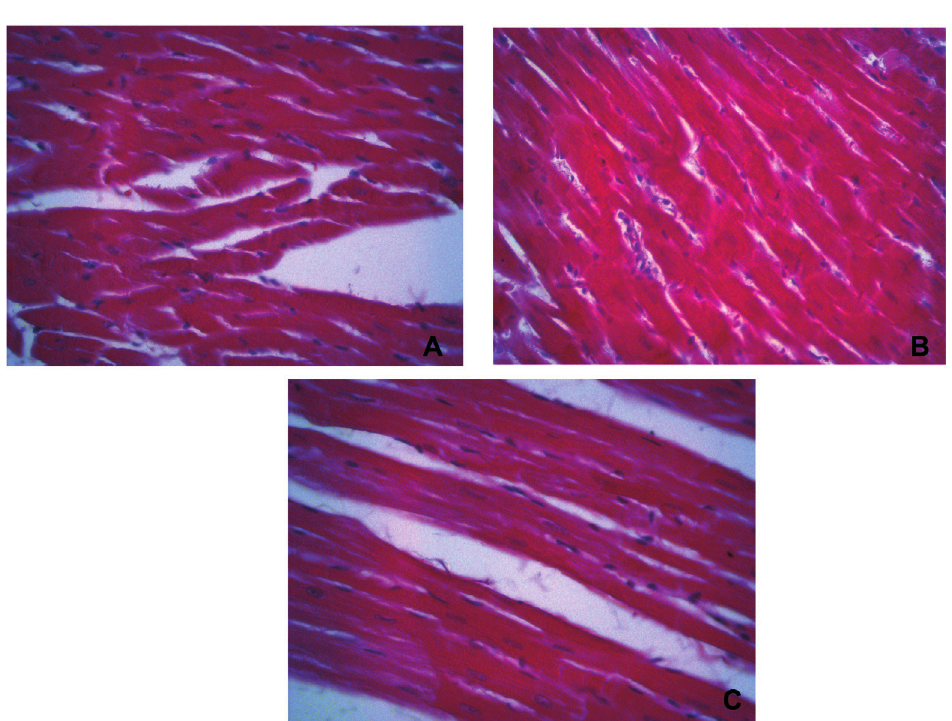
Fig. 1 - Representative left ventricle tissue sections stained with hematoxylin and eosin, showing similar findings of cell preservation in all three groups: (A) HTK, (B) LIRM, and (C) A/G solutions